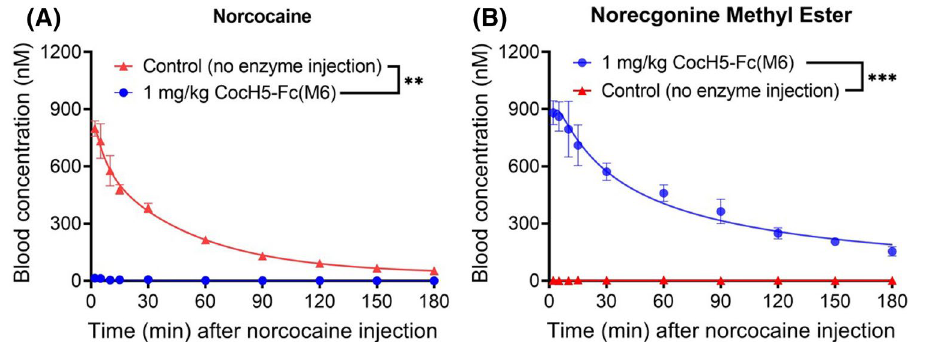
Figure 4. CocH5-Fc(M6)-accelerated clearance of norcocaine in rats in comparison with untreated group (n = 4 per group). Time-dependent concentrations of ( A ) norcocaine and ( B ) norecgonine methyl ester. Statistical significance (paired t test using the GraphPad Prism 8.0 software): * p < 0.05; ** p < 0.01; *** p < 0.001; **** p <